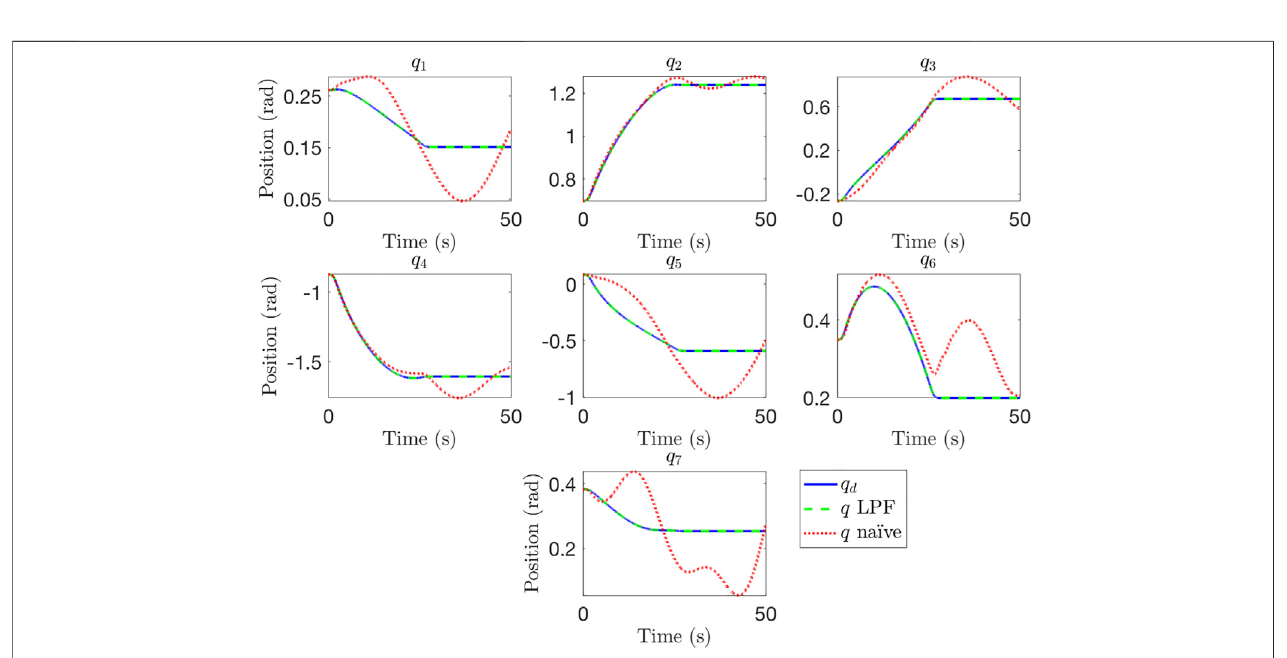
FIGURE 5 | Comparison of joint space performance for a naïve motor trajectory and a trajectory generated using the LPF method.